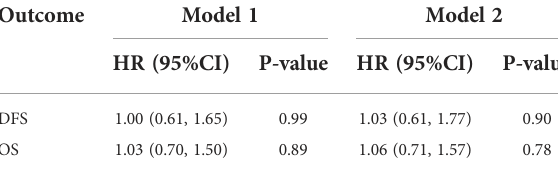
TABLE 5 Different surgical groups and the risk of outcomes.